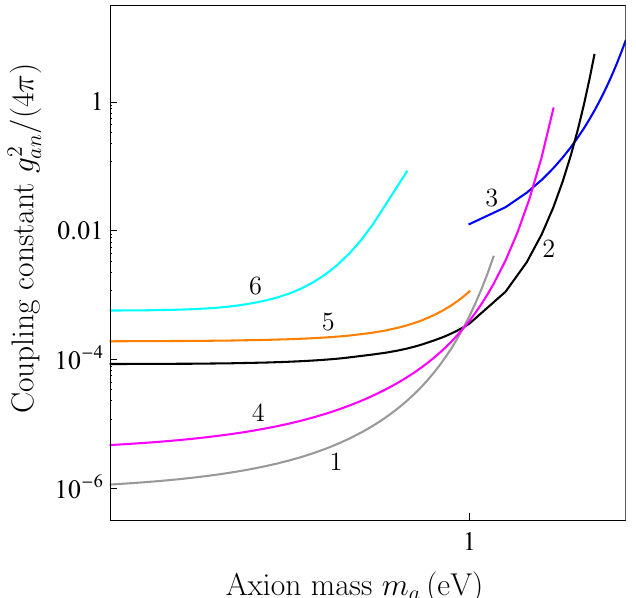
Figure 6. The constraints on the coupling constant of axion to nucleon following from the Casimir-less experiment, experiments on measuring the Casimir pressure and lateral Casimir force (lines 1, 2, and 3, respectively) and from experiments on measuring the difference of Casimir forces, gradient of the Casimir force and Casimir-Polder force (lines 4, 5, and 6, respectively) are shown as functions of the axion mass. The regions above each line are excluded and below each line are